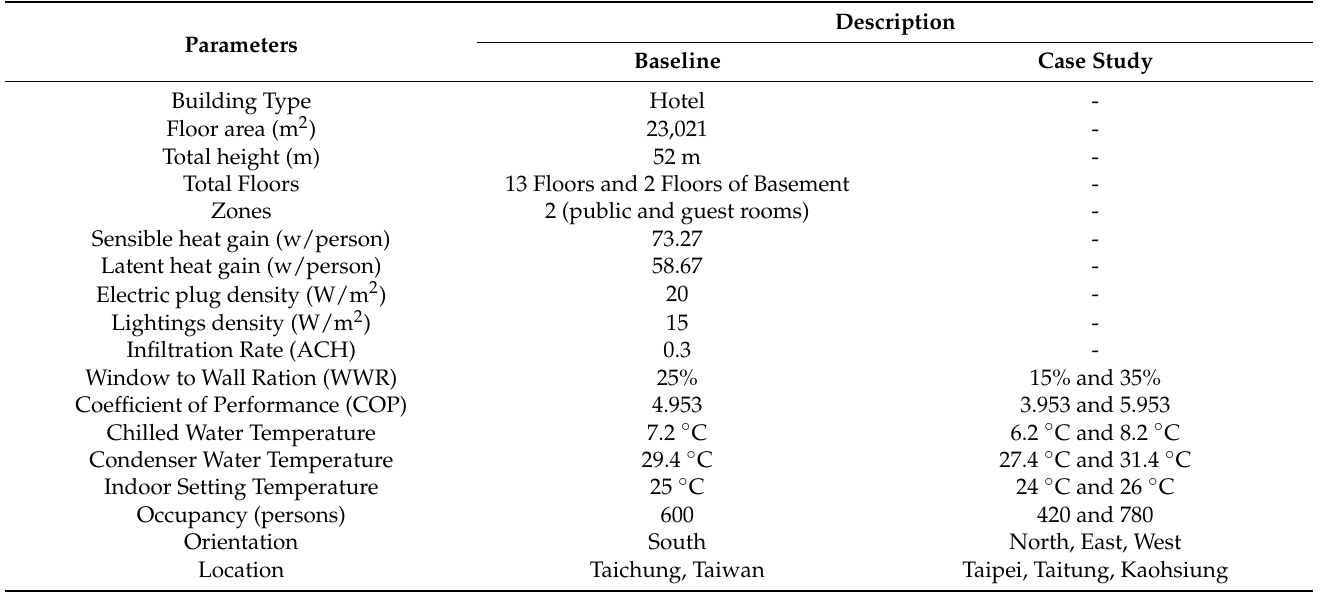
Table 5. Input parameters for energy